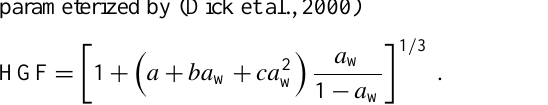
Fig. 1. Size dependence of GF-PDF. GF1 and GF2 represent the mean growth factors of hydrophobic (GF < 1.2) and hydrophilic (GF > 1.2) Fig.1: Size dependence of GF-PDF. GF1 and GF2 represent the mean growth factors of 760 modes, respectively. F2 means the number fraction of hydrophobic (GF<1.2) and hydrophilic (GF>1.2) modes, respectively. F2 means the number 761 fraction of GF2. 762